Question: Identify the chart type used in this figure.
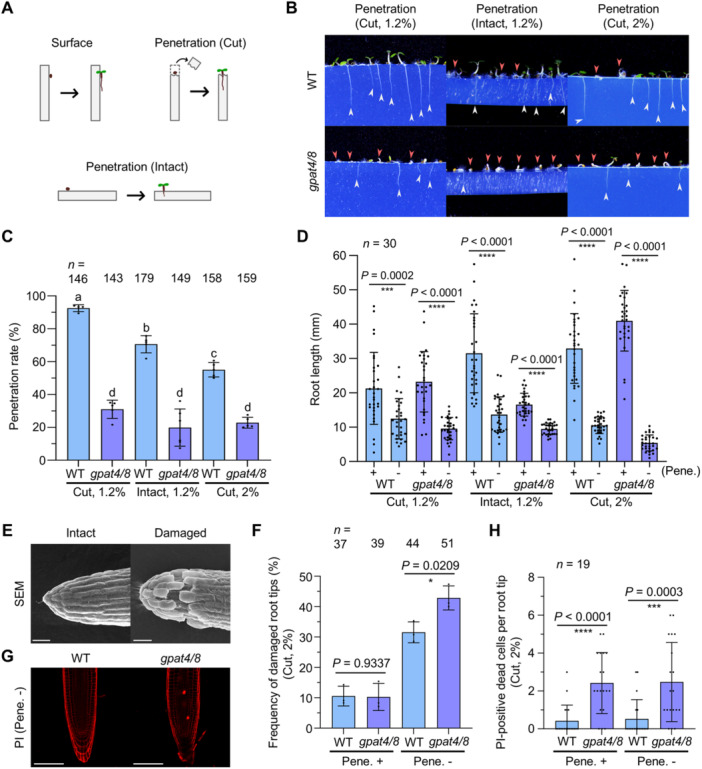
Answer: bar